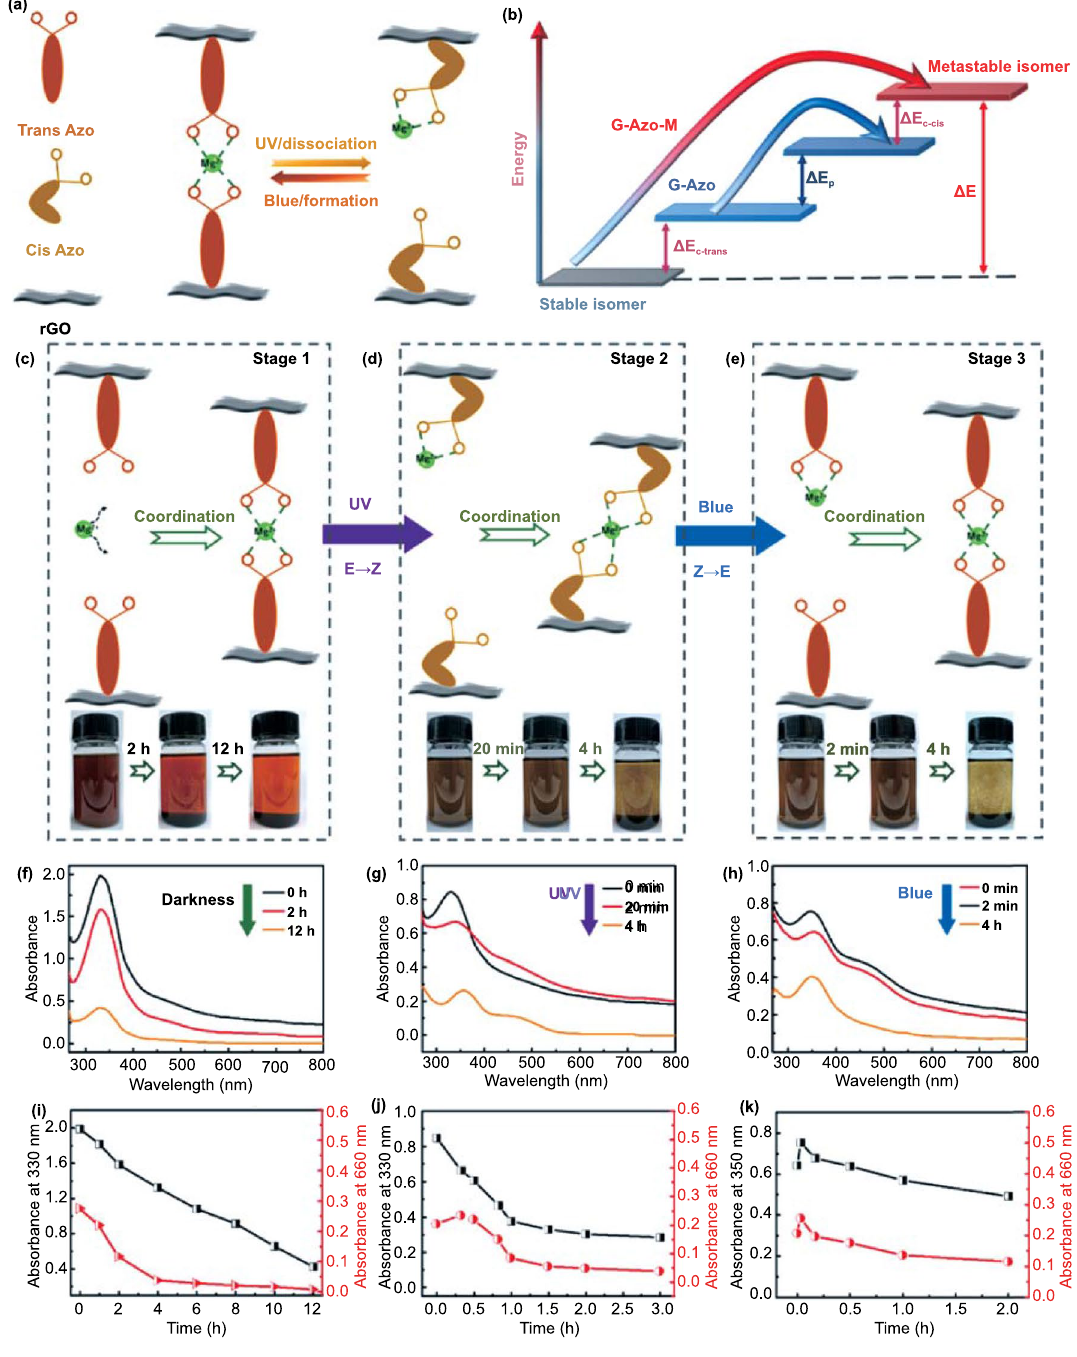
Fig. 9 a Schematic of reversible photoisomerization of G-Azo-Mg film in the solid state with formation and dissociation of coordination bonds. b Schematic energy diagram of G-Azo tuned using coordination bonds. Reversible formation and dissociation of coordination bonds in liquid state. Schematic of the reversible formation and dissociation of G-Azo-Mg for crosslinked self-assembly in DMF solution in c stage 1, d stage 2, and e stage 3. The corresponding photographs of the solution at different time points indicate the dissolution (disassembly) and deposition (assembly). f – h Time-evolved UV–Vis absorption spectra of the solution in stage 1, 2, and 3, respectively, under alternate irradiation of UV and visible lights. i – k Absorption intensity at 330 and 660 nm with elapsed time in stage 1, 2, and 3, respectively